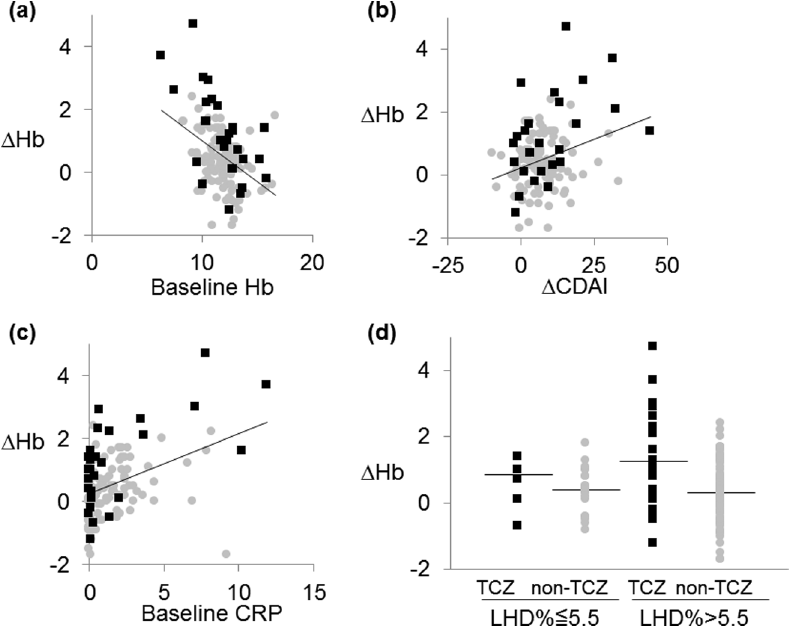
Figure 1. Correlation between the increase of hemoglobin levels and baseline hemoglobin (a), CRP (b), reduction in the clinical disease activity index (c), and baseline LHD% (d). Dot plot suggests the correlation between (a) baseline hemoglobin (Hb) and D Hb (N=147), (b) baseline CRP and D Hb (N=147), and (c) reduction in the clinical disease activity index ( D CDAI) and D Hb (N=122) in rheumatoid arthritis patients treated by TCZ (black closed square) or non-TCZ biologics (gray closed circle). The straight line corresponds to the best-fit linear regression line for all samples. (d) D Hb levels in patients treated with TCZ (black closed square) or non-TCZ biologics (gray closed circle) are expressed in two groups divided by the baseline LHD% value 5.5. The straight lines represent the median levels of D Hb for indicated groups. ( D Hb = Hb at week 12 - Hb at baseline, D CDAI = CDAI at baseline – CDAI at week 12; LHD%= low hemoglobin density.)